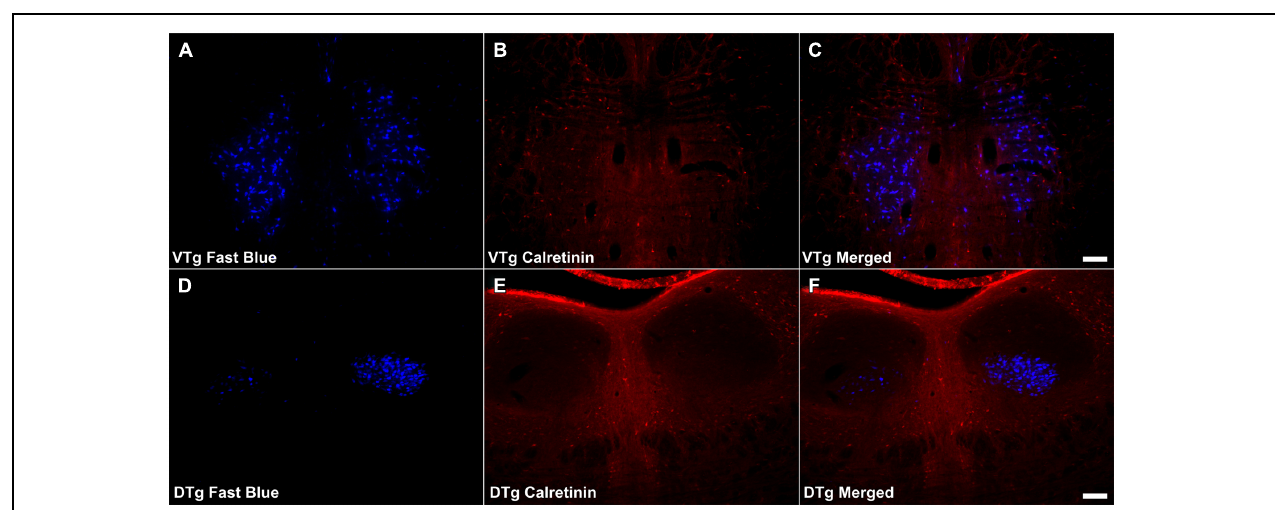
came from visualization of the overlapping grayscale peaks of tracer (blue) and CB (yellow), an example of which is shown in (C). Moderate neuropillar CB immunoreactivity was present in VTg and was densest ventromedially. Neuronal CB immunoreactivity was present and a notable number of these cells was found to co-localize retrogradely labeled Fast Blue fluorescence. In DTg, CB immunoreactivity was virtually absent except for a few centrally located neurons, which did not co-localize retrogradely transported Fast Blue fluorescence. Scale bars: 100 µ m.